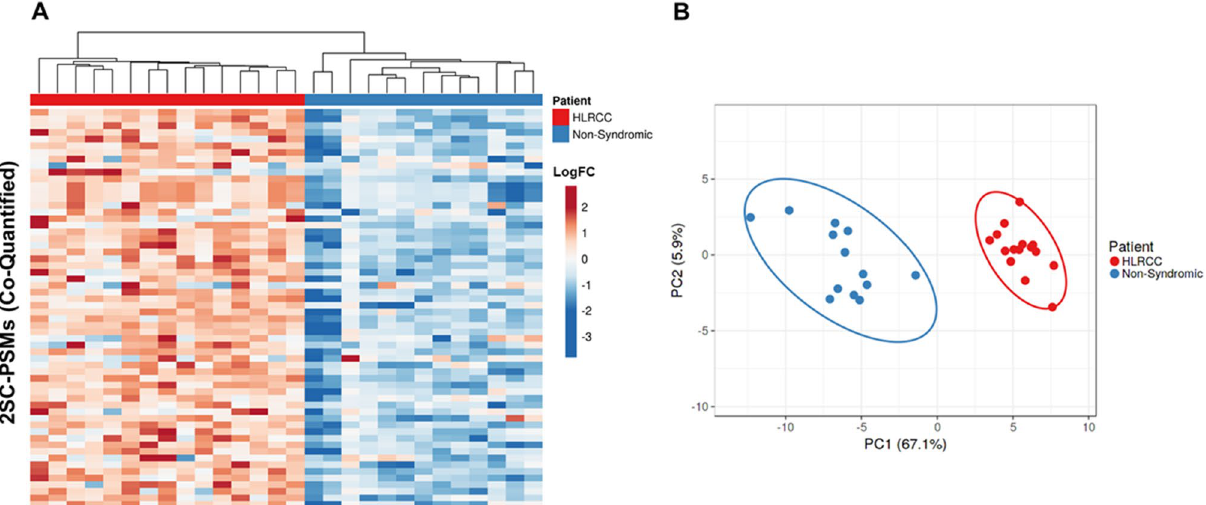
Figure 7. Unsupervised cluster analysis of quantified peptides exhibiting 2-succinyl modified cysteine residues in uterine leiomyomas (ULMs) from Hereditary Leiomyomatosis and Renal Cell Cancer (HLRCC) and non-syndromic (NS) patients. ( A ) Heatmaps detail 60 peptide spectral matches (PSMs) encoding 2-succinyl modified cysteine residues quantified in HLRCC and non-syndromic ULMs; clusters organized by correlation and average linkage (ClustVis). ( B ) Principle component analyses of these 60 2SC-PSMs revealed the abundance of these features can explain 67.1% of the variance (PC1) and 5.9% of the variance (PC2) between these patient cohorts; median difference of 2SC-PSMs = 1.86, MWU p < 0.0001.